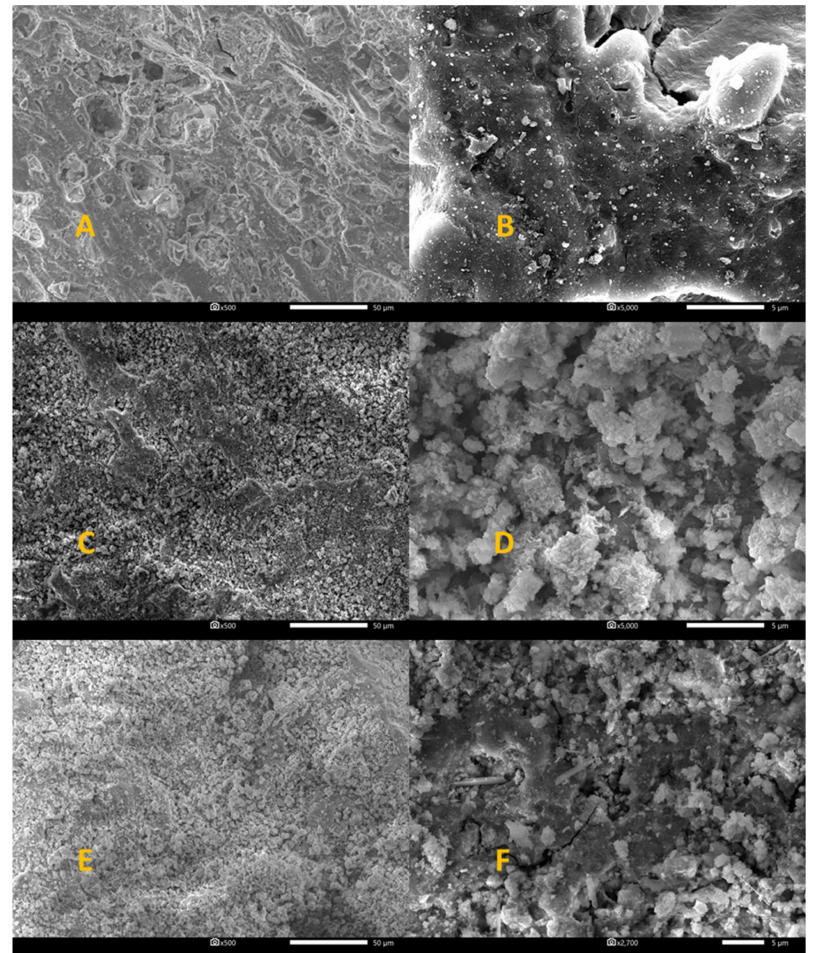
Figure 6. SEM images of NiW/Ph-HCl ( A ) { × 500}, ( B ) { × 5000}), NiMo/Ph-HCl ( C ) { × 500}, ( D ) { × 5000}) and CoMo/Ph-HCl ( E ) { × 500}, ( F ) { ×